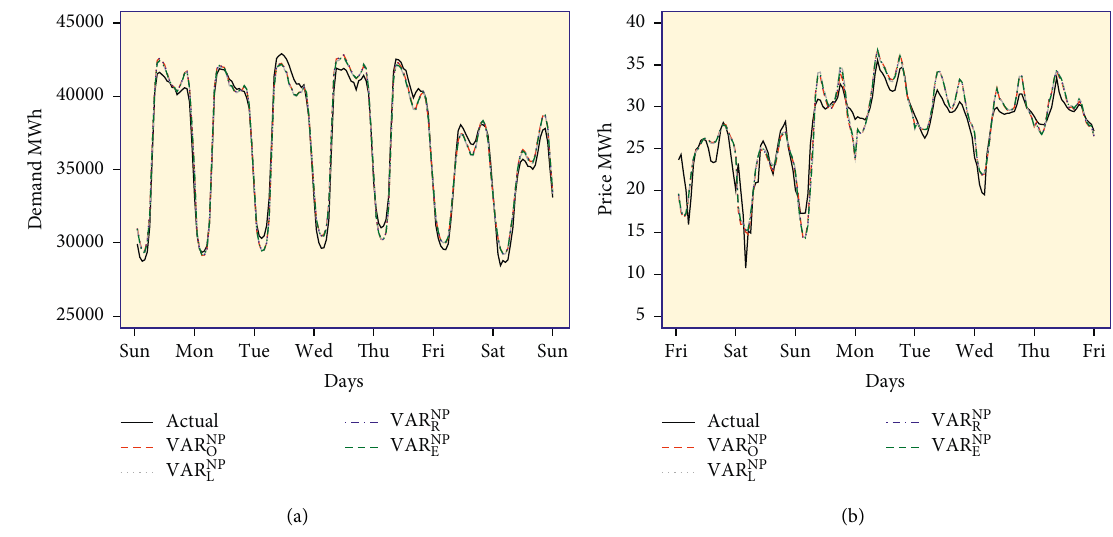
Figure 6: The observed and forecasted electricity demand (a) and prices (b) for four best models over a week